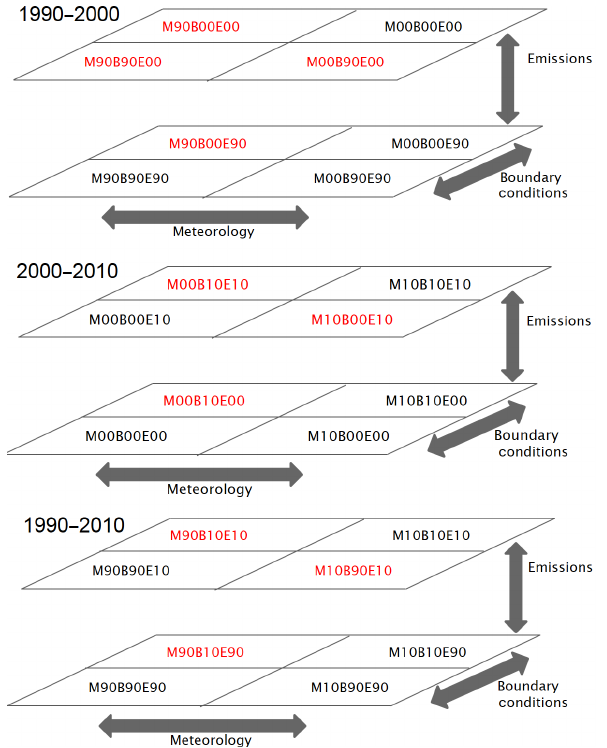
Figure 1. Combination of sensitivity simulations required to per- form the analysis of the contribution of (i) meteorology, (ii) bound- ary conditions, and (iii) emission changes for the 1990–2000, 2000– 2010, and 1990–2010 years from the top to the bottom. The key to EDT model simulations provides the 2-digit modelled year for me- teorology (M), boundary conditions (B), and emissions (E). Black labels are for the simulations included in the experiment, and red labels are the combinations not produced in any of the tiers of ex-